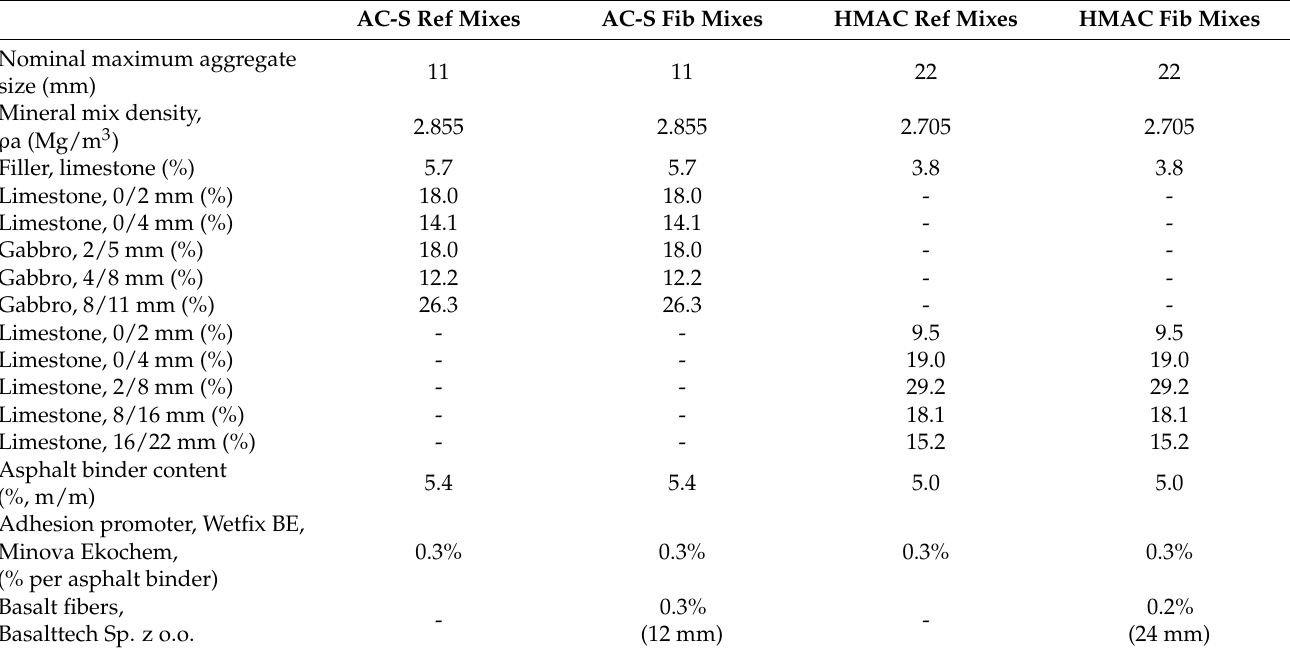
Table 2. Composition of the investigated asphalt